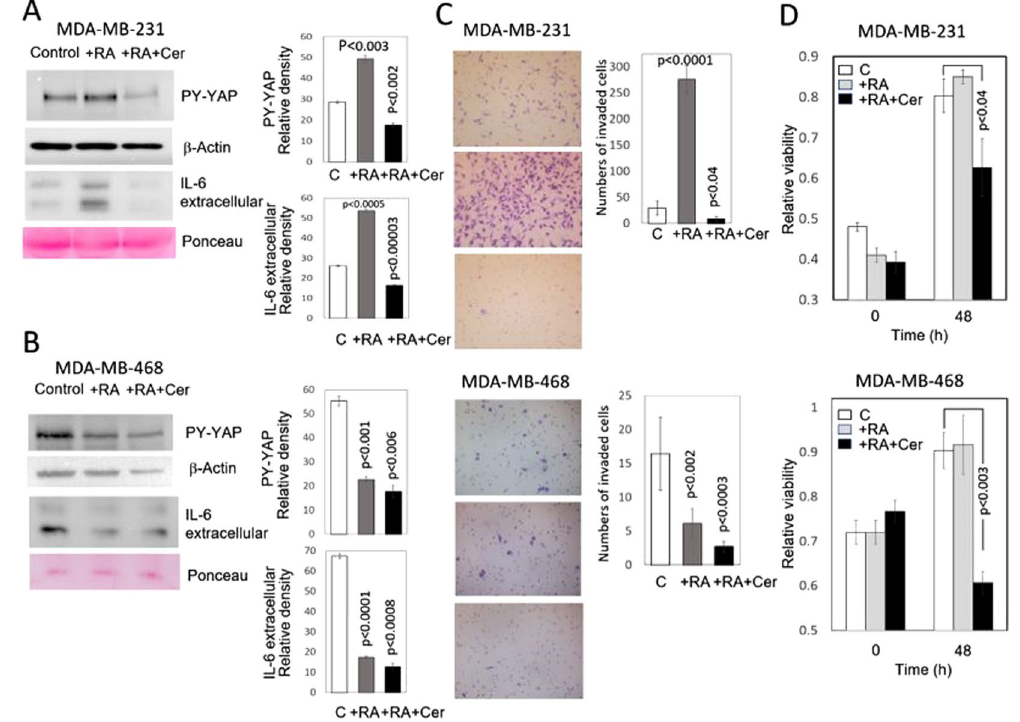
Figure 4. Effect of RA and RA plus cerivastatin on nuclear YAP, IL-6 expression, and invasiveness in vitro of triple-negative MDA-MB-231 and MDA-MB-468 breast cancer cells. MDA-MB-231 and MDA-MB-468 breast cancer cells were incubated for two days in the presence ( + RA) of retinoic acid (5 μ M) or the presence of RA (5 μ M) plus cerivastatin (1 μ M) (RA + Cer). ( A ) Western blots of nuclear extracts and culture medium of MDA-MB-231 cells treated with RA show the increase of nuclear tyrosine phosphorylated YAP and extracellular IL-6. These actions were reverted when cells were treated with cerivastatin plus retinoic acid. The bar graphs show quantification of data from three independent experiments. β -Actin and Ponceau staining were used as loading control. ( B ) Western blots of nuclear extracts and culture medium of MDA-MB-468 cells treated with RA show the decrease of nuclear PY-YAP and extracellular IL-6. No major additional changes were observed when cells were treated with cerivastatin plus retinoic acid. The bar graphs show quantification of data from three independent experiments. β -Actin and Ponceau staining were used as loading controls. The density of PY-YAP was normalized to the amount of β -Actin. ( C ) To assess the effect of RA and RA + cerivastatin on invasiveness of MDA-MB-231 and MDA-MB-468 cells in vitro , treated breast cancer cells were seeded on polycarbonate filters coated with Matrigel, as described in the Materials and Methods Section, and incubated for 24 h. Quantification of invaded cells represents the mean number of cells per field counting seven random fields at 40 × or 20 × magnification. Treatment with 5 μ M RA markedly increased cell invasion in MDA-MB-231 cells (P < 0.0001 vs. control cells) while a decrease was observed in MDA-MB-468 cells. Treatment with RA (5 μ M) plus cerivastatin (1 μ M) suppressed cell invasion in both types of cells. ( D ) Cell viability of MDA-MB-231 and MDA-MB-468 breast cancer cells incubated in the presence of RA (5 μ M) or RA (5 μ M) plus cerivastatin (1 μ M). Cells were incubated for 48 h in the presence of RA or RA plus cerivastatin. In both